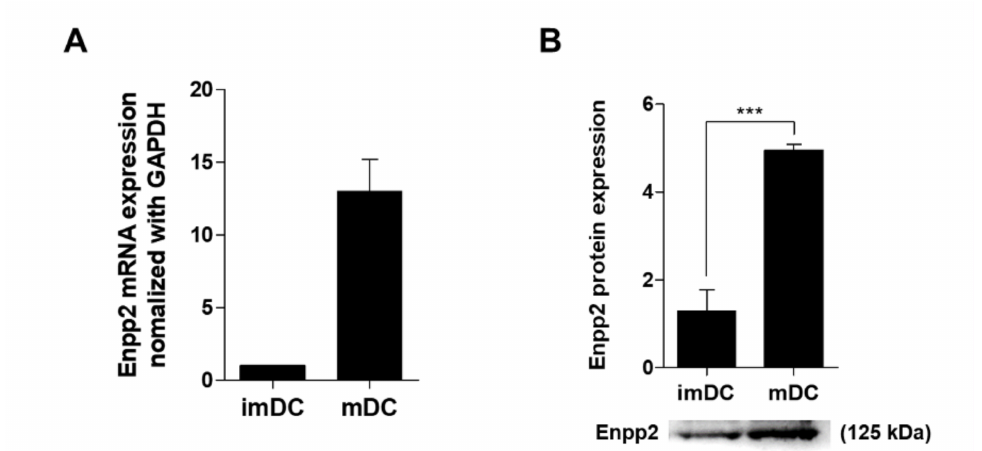
Figure 5. Human mDCs secrete high levels of Enpp2. ( A ) Human DC subsets (imDC and mDC) were cultured, and Enpp2 expression measured by qRT-PCR. Values were normalized to GAPDH expression. Data are expressed as the mean ± SEM ( n = 5 independent DC preparations) of duplicate experiments. ( B ) Levels of secreted Enpp2 protein in concentrated (20-fold) conditioned serum free media (SFM) from DCs was detected by western blotting. The bar graphs show data derived from densitometric analysis of western blot data. Values are expressed as the mean ± SEM ( n = 3 independent experiments). *** p < 0.001 compared with